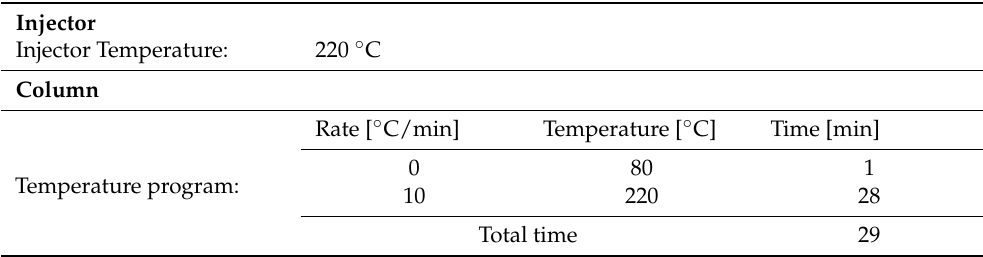
Table 1. Method for analyzing the chemical composition of Ferula assa-foetida L. extract using a gas chromatograph coupled to a mass detector.